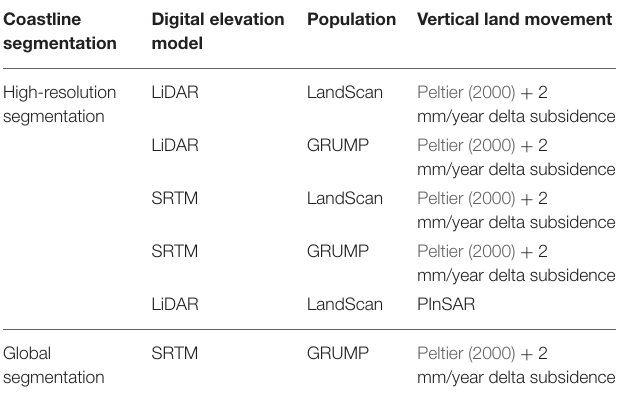
TABLE 1 | Datasets used to investigate the sensitivity of coastal impacts to the four uncertainty dimensions (coastline segmentation, elevation, population, and vertical land